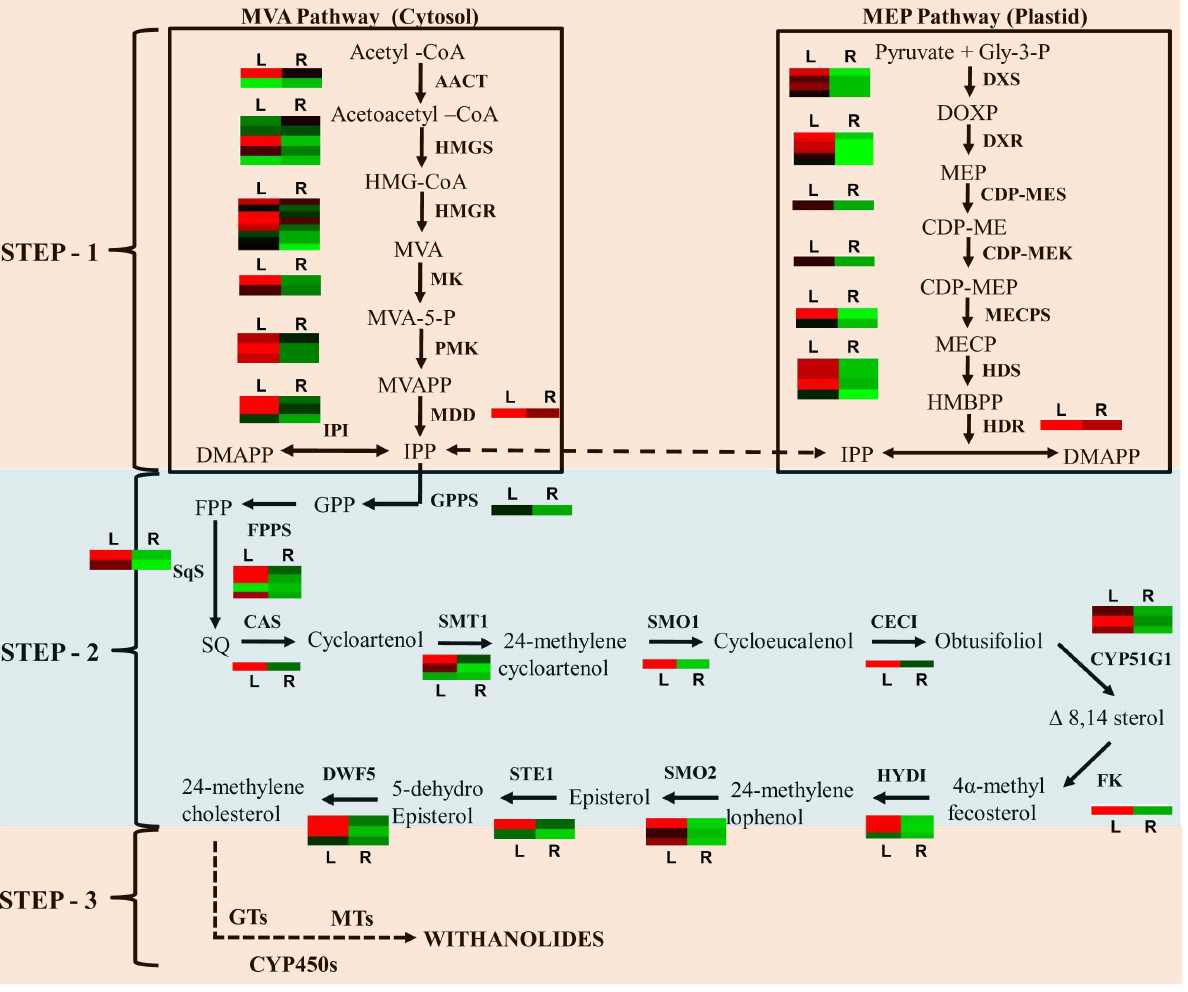
Figure 5. Putative pathway for withanolide biosynthesis in Withaniasomnifera . All the enzymes found in this study related to different steps are shown between the reactions catalyzed. Expression of different contigs related to these enzymes in leaf and root is shown by heatmap. Broken arrow in Step 3 represents putative steps involving CYP450s, GTs and MTs. Names of the enzymes identified are provided in Table 4.